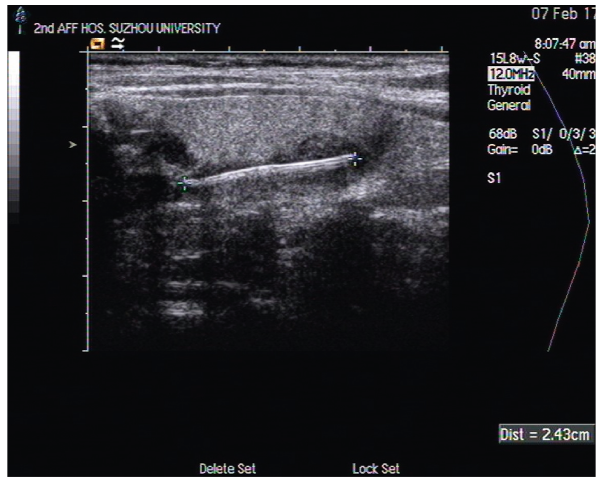
Figure 1: The features of ultrasonography. The presence of a for- eign body that was approximately 2.43cm hyperechoic linear image embedded in the left part of the thyroid lobe, and part of it was located outside the back membrane of the thyroid. A hypoechoci area surrounding the foreign body is regarded as the ultrasonic characteristics of inflammatory response.